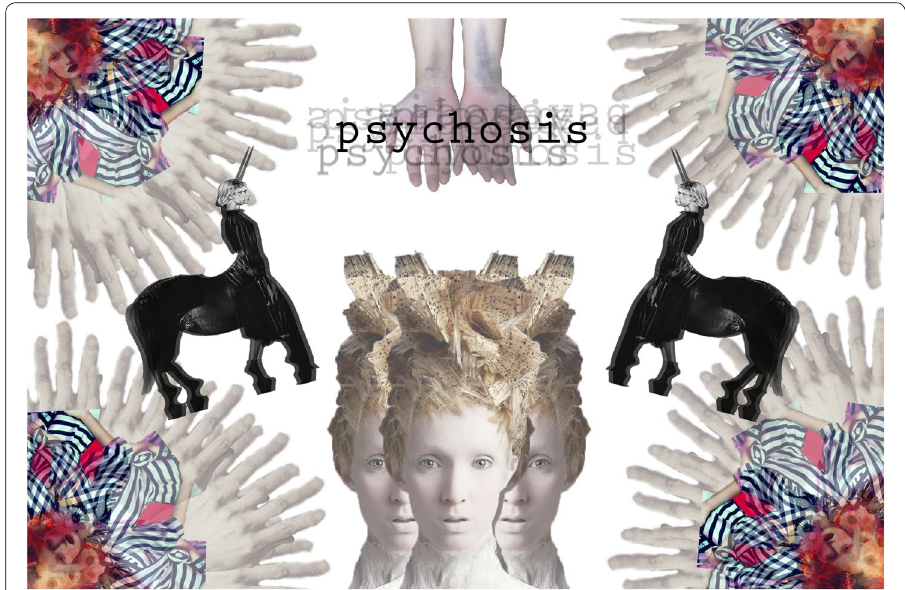
Fig. 2 Example of Category 2 concept